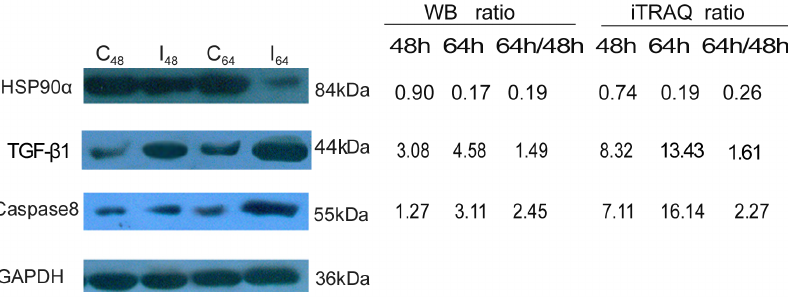
Figure 5. Western blot confirmation for three differentially expressed proteins (caspase-8, HSP90 a , and TGF- b 1). Following TGEV and mock infection of the ST cells, equal amounts of protein were separated by SDS-PAGE and transferred to PVDF membranes. The membranes were then probed with the specified antibody, and the identified bands were visualized. GAPDH was used as an internal control to normalize the quantitative data. The representative images shown are typical of two independent experiments. At 48 hpi (I 48 ), integrated optical density (IOD) analysis showed an upregulation of caspase-8 (1.27 fold) and TGF- b 1 (3.08 fold), but HSP90 a was almost unchanged (0.90 fold). At 64 hpi (I 64 ), we observed an upregulation in both caspase-8 (3.11 fold) and TGF- b 1 (4.58 fold), but a 5.82 fold downregulation of HSP90 a . The IOD was normalized against GAPDH.